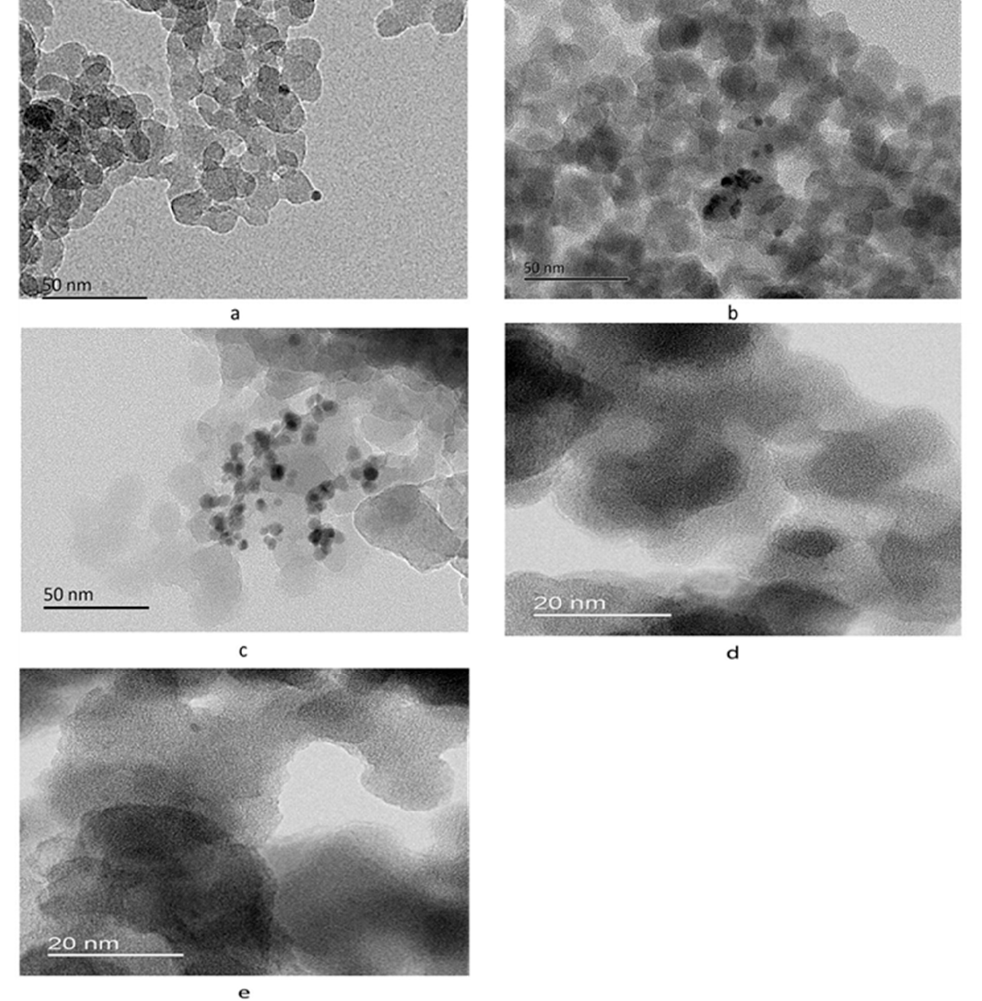
Figure 5. TEM images of synthesized catalysts: ( a ) 0.2% Pd/SiO 2 (6 Pd particles); ( b ) 0.2% Pd-AlPO-5/SiO 2 (8 Pd particles); ( c ) 0.2% Pd-AlPO-8/SiO 2 (18 Pd particles); ( d ) 0.2% Pd-AlPO-11/SiO 2 (6 Pd particles); ( e ) 0.2% Pd-AlPO-31/SiO 2 (5 Pd particles).